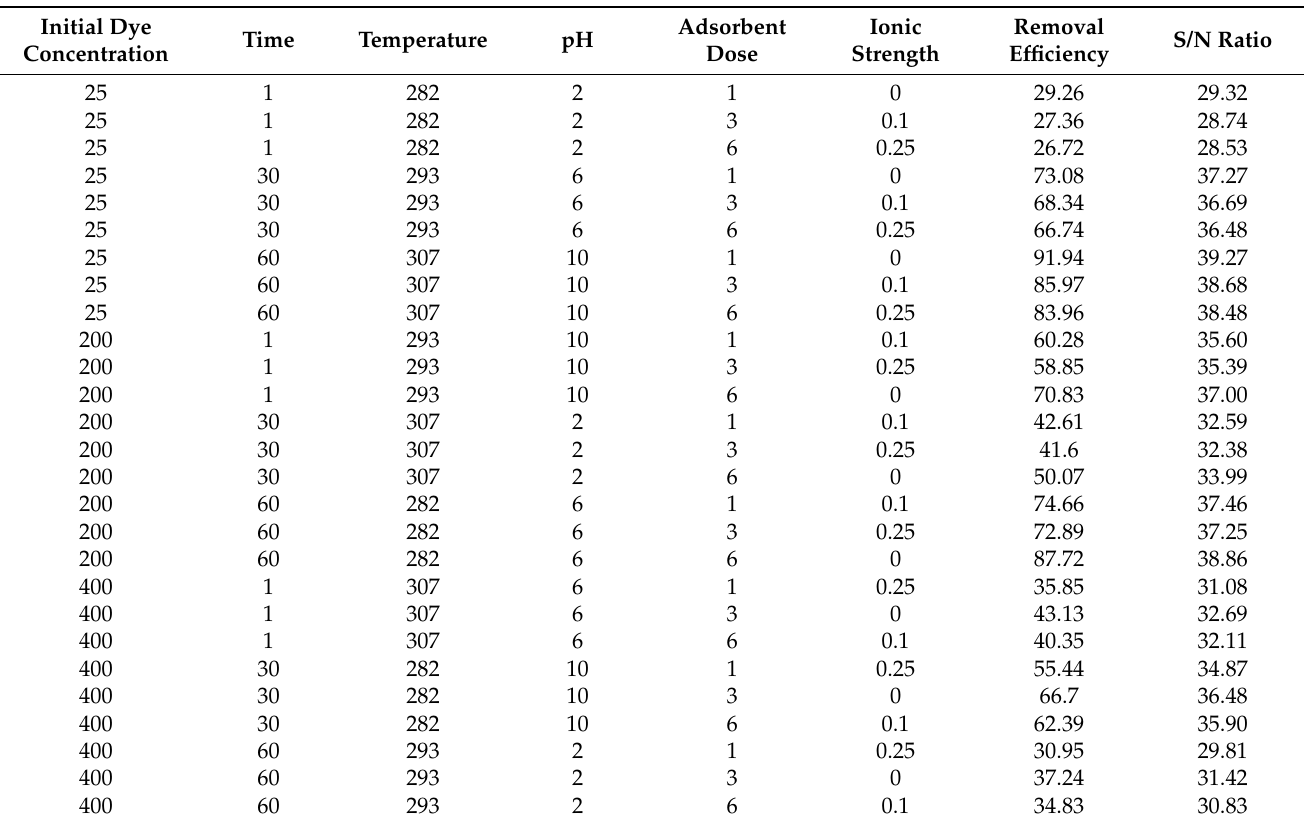
Table 6. The experimental results obtained for crystal violet removal efficiency and the corresponding S/N ratios using the Taguchi L27 orthogonal